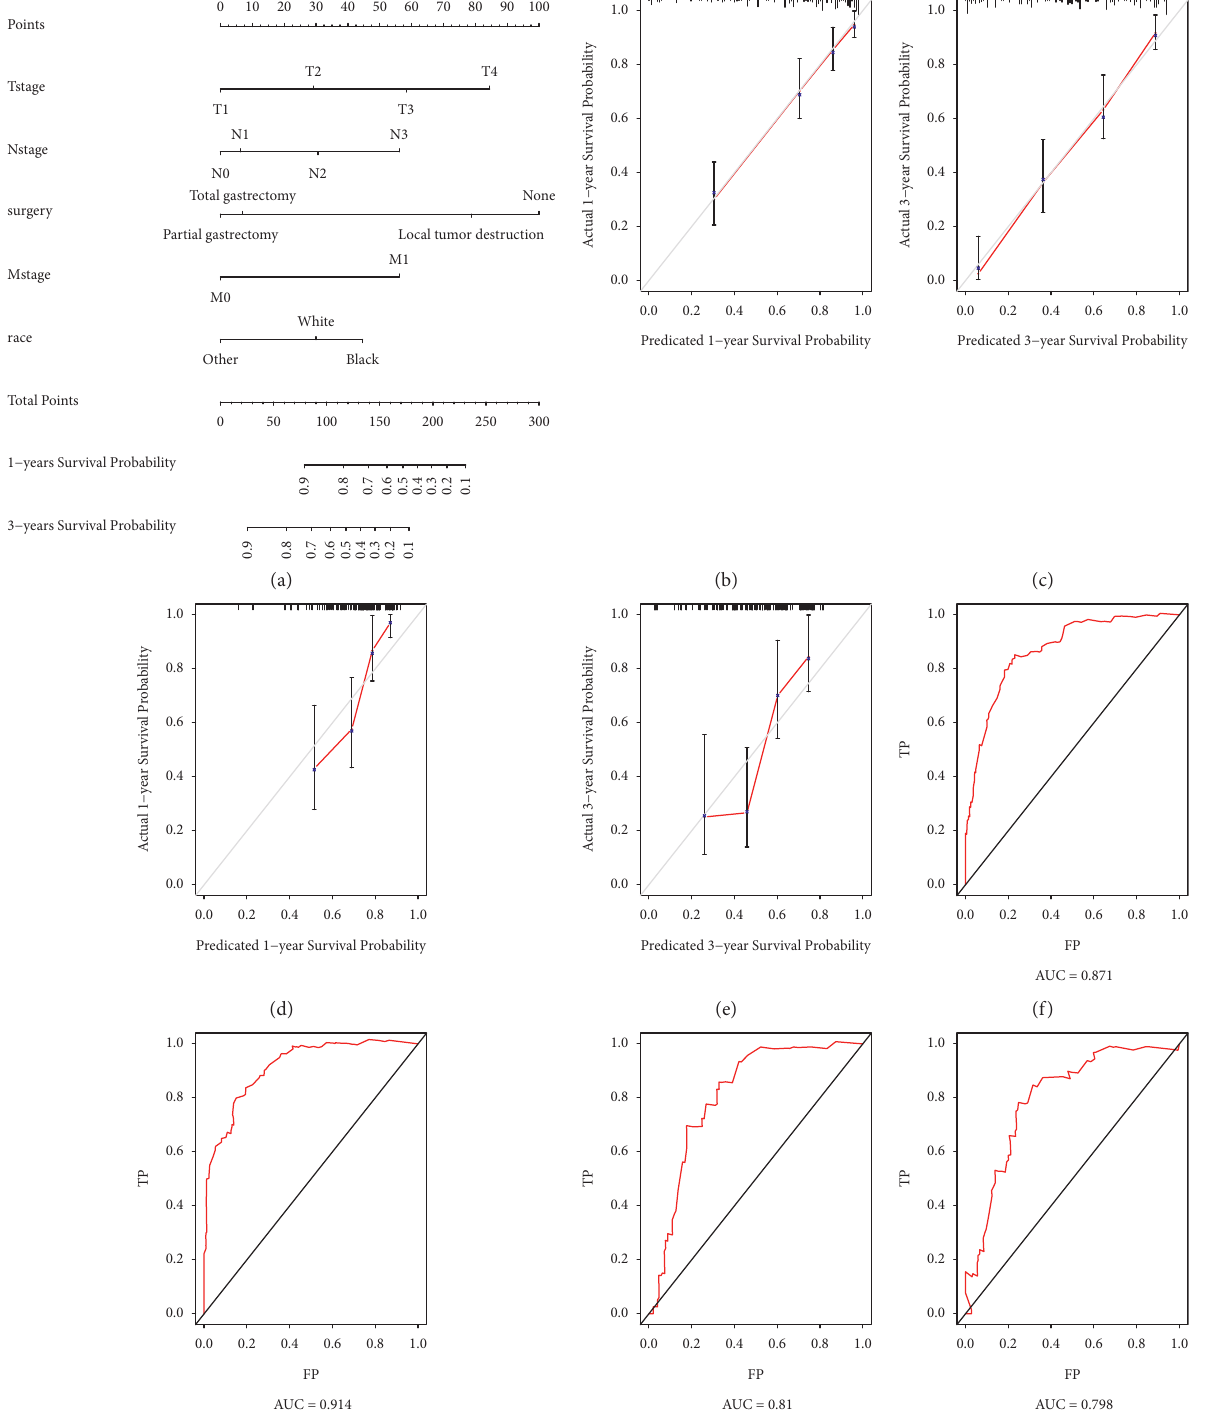
Figure 5: The nomogram (a) to predict the 1-year and 3-year cancer-specific survival (CSS) rates of GC patients with adenocarcinoma with mixed subtypes (AM). The calibration curve to verify the predictive ability for 1-year and 3-year CSS using variables from our developed nomogram in the training cohort (b, c) and validation cohort (d, e). The receiver operating characteristic (ROC) curve to verify the predictive ability for 1-year and 3-year CSS using variables from our developed nomogram in the training cohort (f, g) and validation cohort (h,